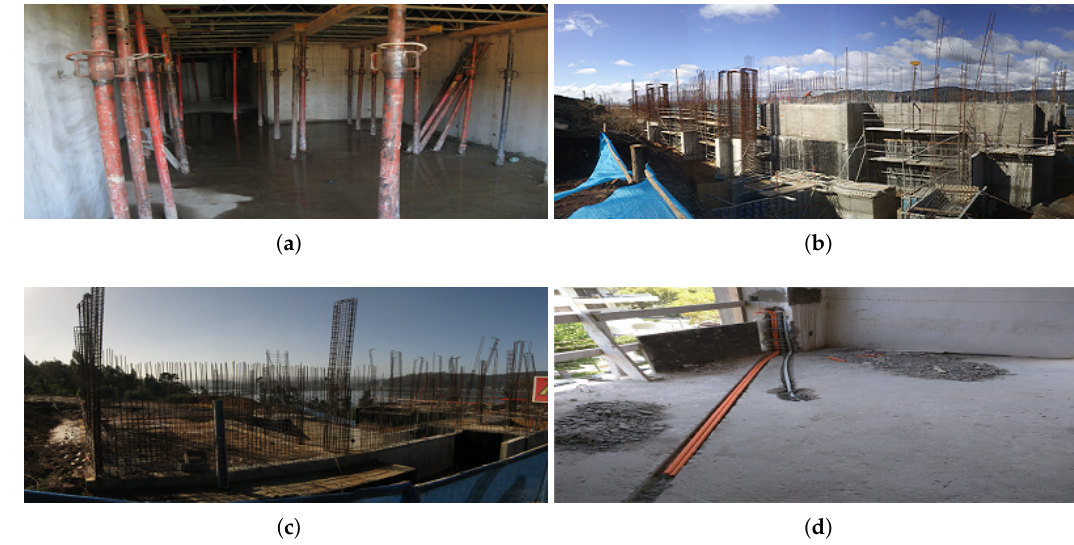
Figure 1. Dynamic environment: construction areas; ( a ) formwork system, ( b ) distribution of a formwork system, ( c , d ) common cracks in construction environments. The images are courtesy of the Department of Design and Theory of Architecture of the University of Bio